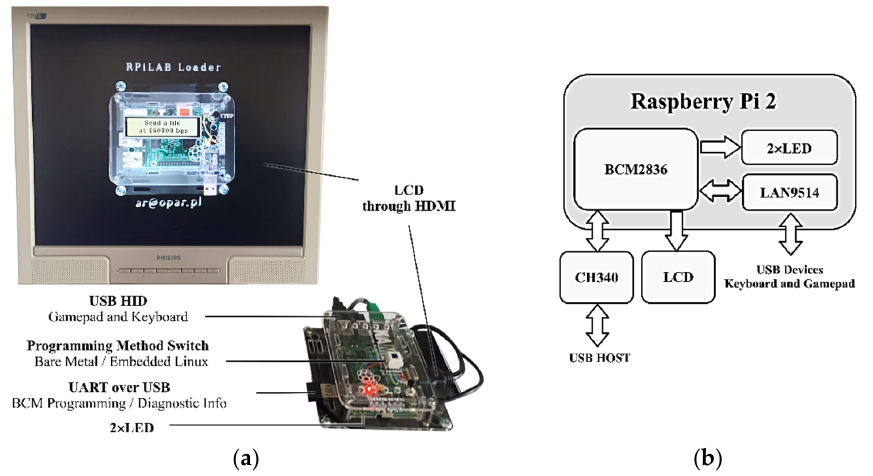
Figure 3. RPILAB module: ( a ) main components; ( b ) internal ‐ structure block diagram.